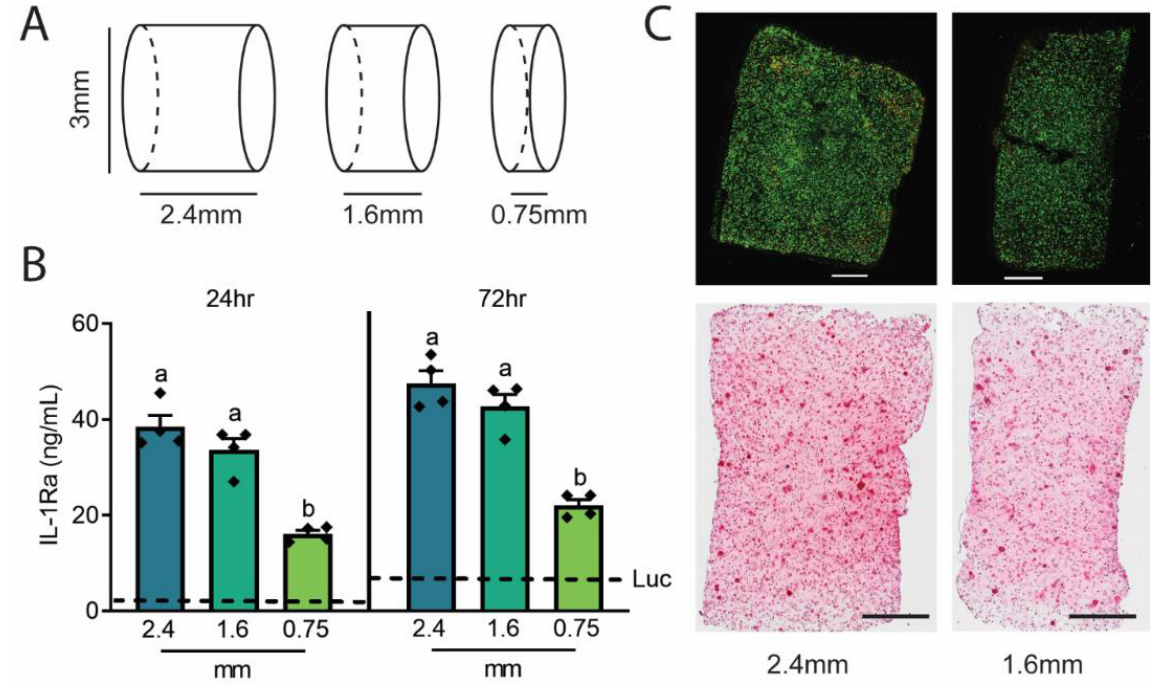
Figure 1. ( A ) Schematic of agarose constructs of different thicknesses (2.4 mm [surface area = 36.8 mm 2 ], 1.6 mm [29.2 mm 2 ], and 0.75 mm [21.2 mm 2 ]) loaded with Ccl2-IL1Ra iPSCs at the same cell densities and stimulated for chondrogenesis for 3 weeks. ( B ) After 24 h and 72 h of 1 ng/mL IL- 1α treatment, the 2.4 and 1.6 mm constructs loaded with Ccl2-IL1Ra iPSCs produce similar levels of IL- 1Ra, significantly exceeding the IL-1Ra production levels in the 1.6 mm construct loaded with Ccl2- Luc cells shown by dashed lines. ( C ) Fluorescent live/dead labeling (green = live; red = dead) show uniformly distributed live cells throughout the thickness of the 2.4 and 1.6 mm constructs, as well as relatively uniform proteoglycan staining by Safranin-O, scale bars: 500 µm. One-way ANOVA with Tukey’s post -hoc test, n = 4 – 5/group/timepoint. Different letters (a,b) indicate groups are sig- nificantly different from one another ( p < 0.05).